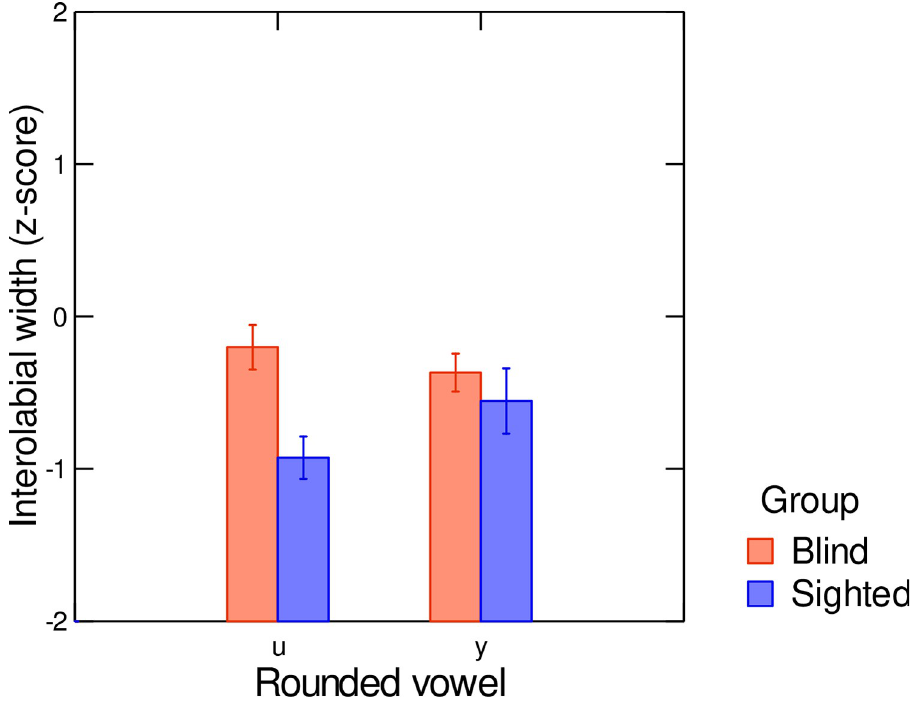
Fig 8. Average values of interolaboal width of vowel stimuli /u/ and /y/ produced by blind and sighted speakers. All data were z-scored. Error bars are standard errors.